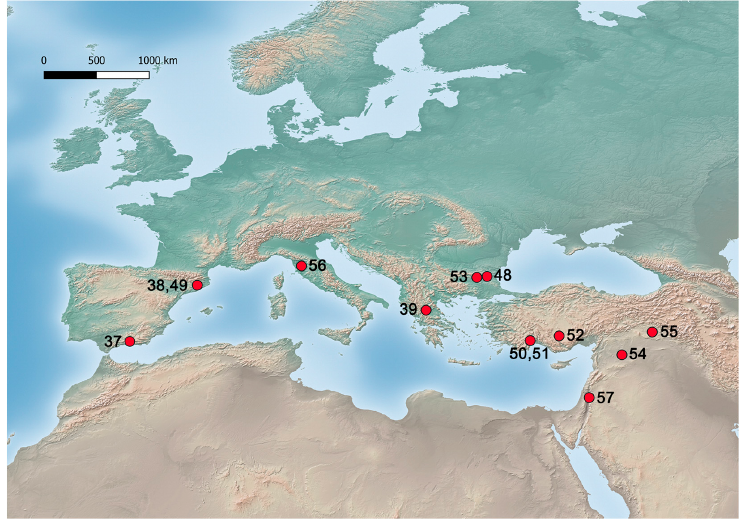
Figure 6. Late Upper Pleistocene (MIS 2) sites where Celtis remains were reported (numbers in the figure correspond to ID numbers in Table 3) (map generated using QGIS version 3.4.13; Source: Natural Earth Data).